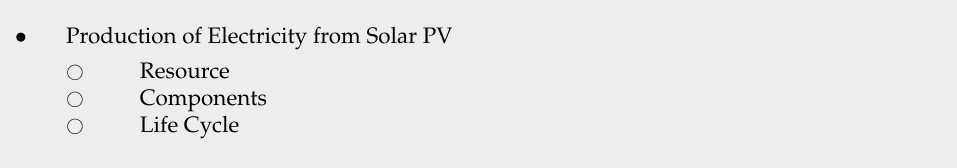
Table 3. Hierarchy for the Production of Electricity from Solar PV.